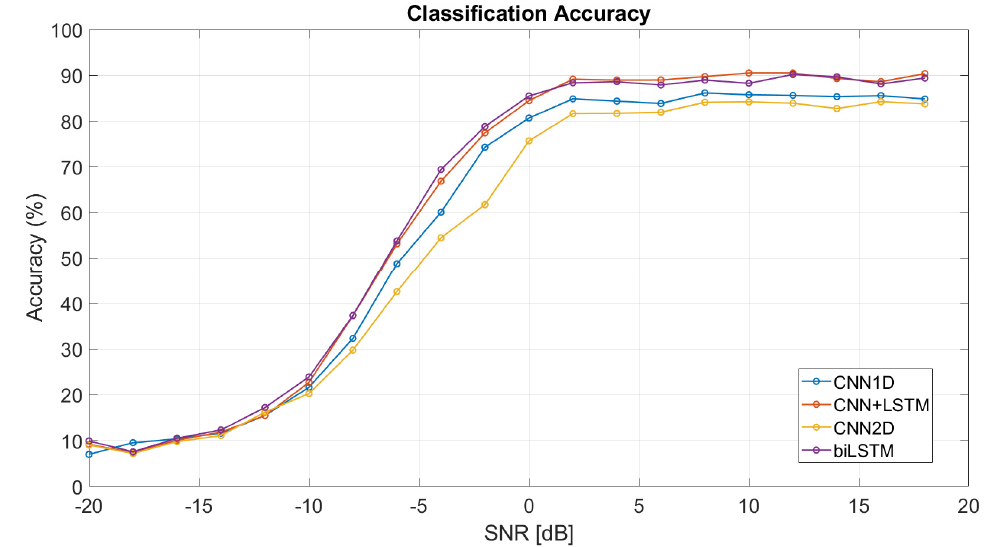
Figure 19. Classification accuracy of each model as function of SNR.